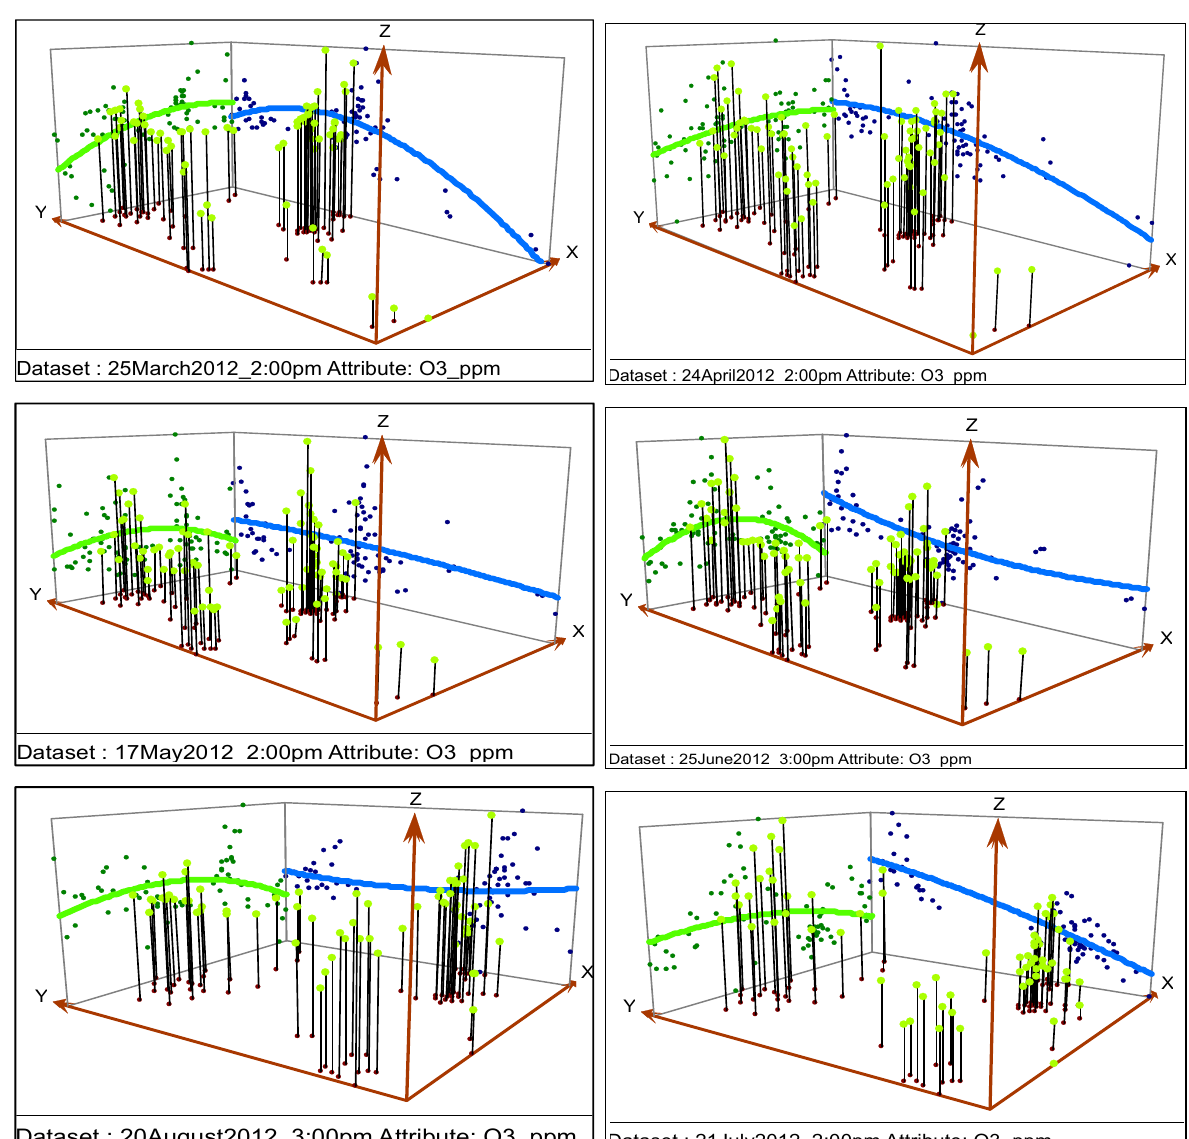
data for the studied 3